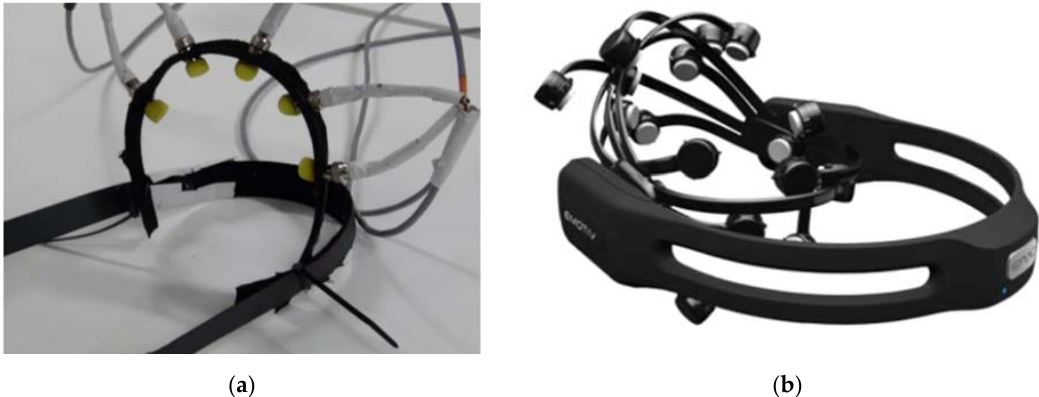
Figure 7. The used EEG headsets for this research: ( a ) in-house developed 5-electrodes EEG headset using the OpenEEG project; ( b ) the Epoc+ headset with 14 electrodes by Emotiv.